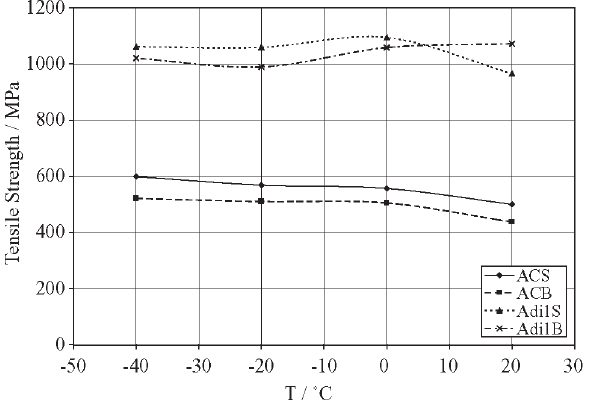
Table 5. Fractomechanical parameter J test results, average values of three measurements. * K